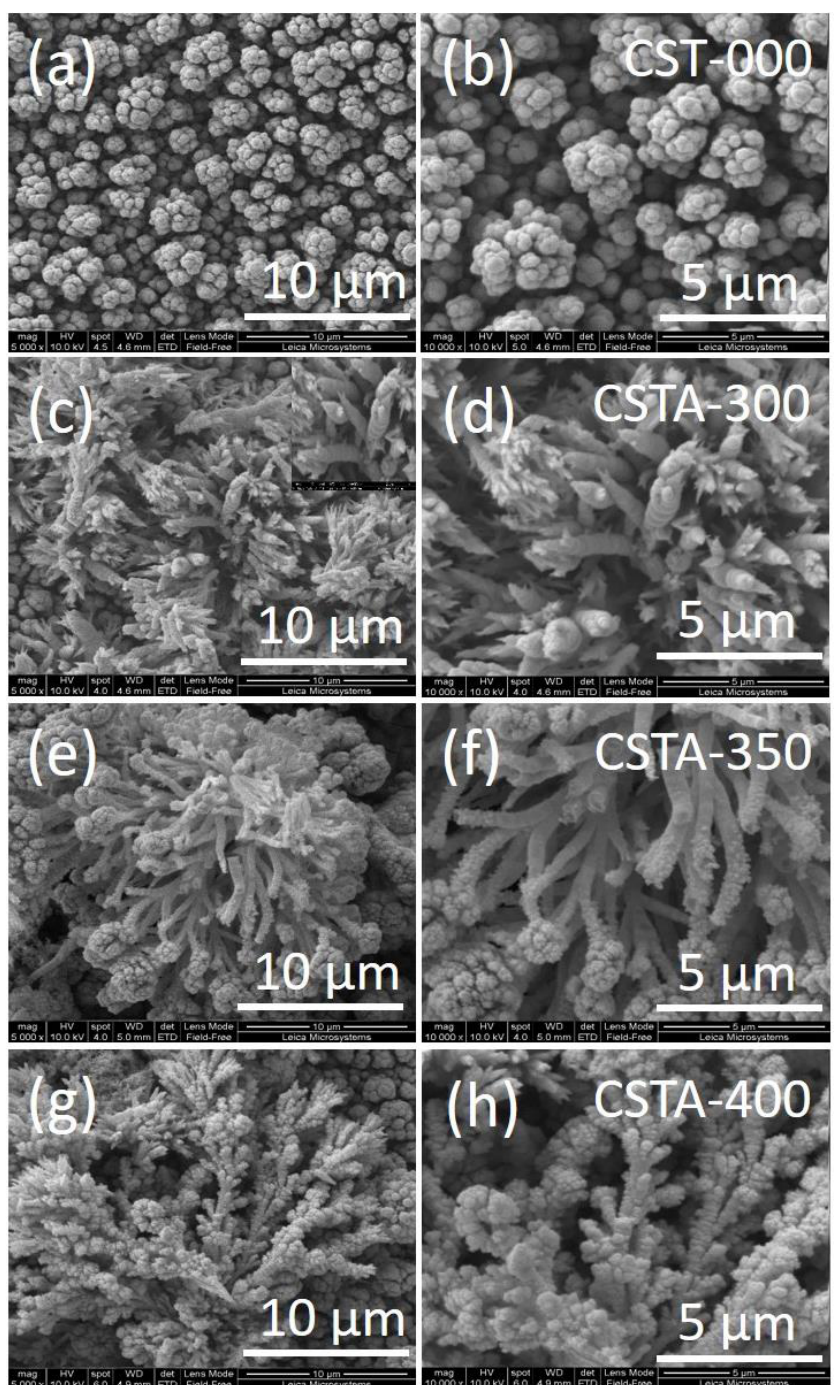
Figure 2. FE-SEM images of the CdSe 0.6 Te 0.4 thin films non-annealed using the ( a , b ) electrochemical method, at air annealing temperatures of ( c , d ) 300 ° C, ( e , f ) 350 ° C, and ( g , h ) 400 ° C. Scale bars in method, at air annealing temperatures of ( c , d ) 300 ◦ C, ( e , f ) 350 ◦ C, and ( g , h ) 400 ◦ C. Scale bars in ( a , c , e , g ): 10 µm; ( b , d , f , h ): 5 µm. ( a , c , e , g ): 10 µ m; ( b , d , f , h ): 5 µ